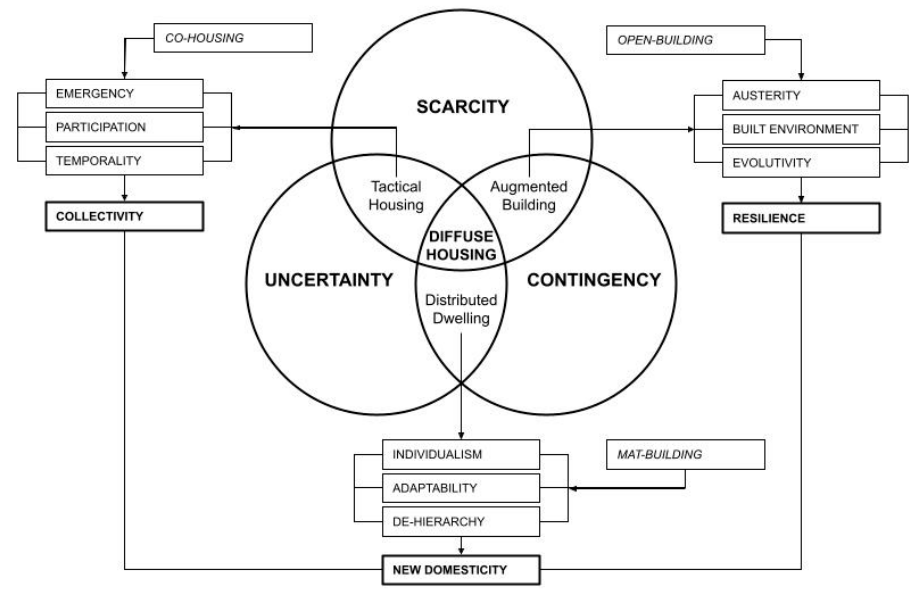
Figure 6. Theoretical outcome. Author’s own construction, 2020.